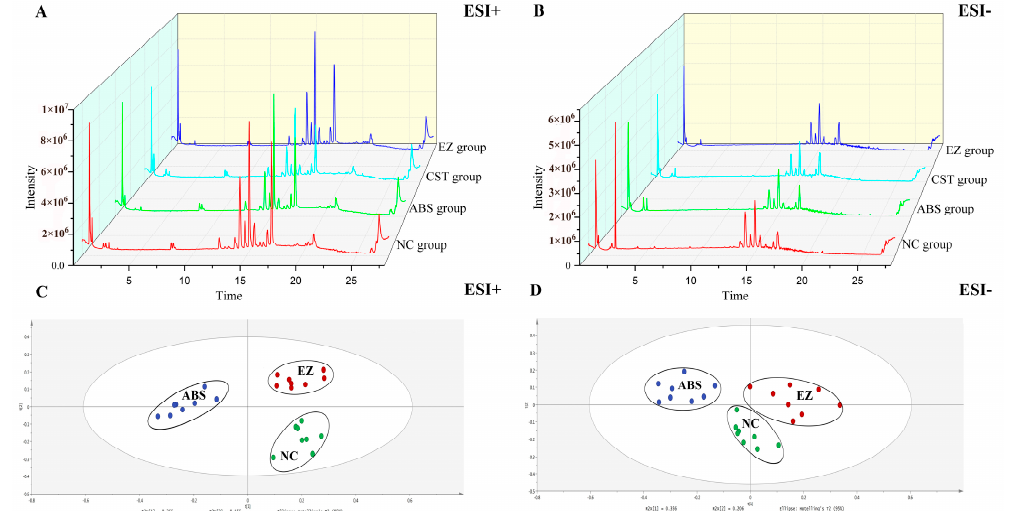
Figure 2. UPLC-Q/TOF-MS total ion chromatograms (TIC) of plasma samples among NC, ABS, CST, and EZ groups in ESI+ mode ( A ) and ESI − mode ( B ); PCA score plots of plasma metabolic profiling of NC, ABS, and EZ in ESI+ mode ( C ) and ESI − mode ( D ).